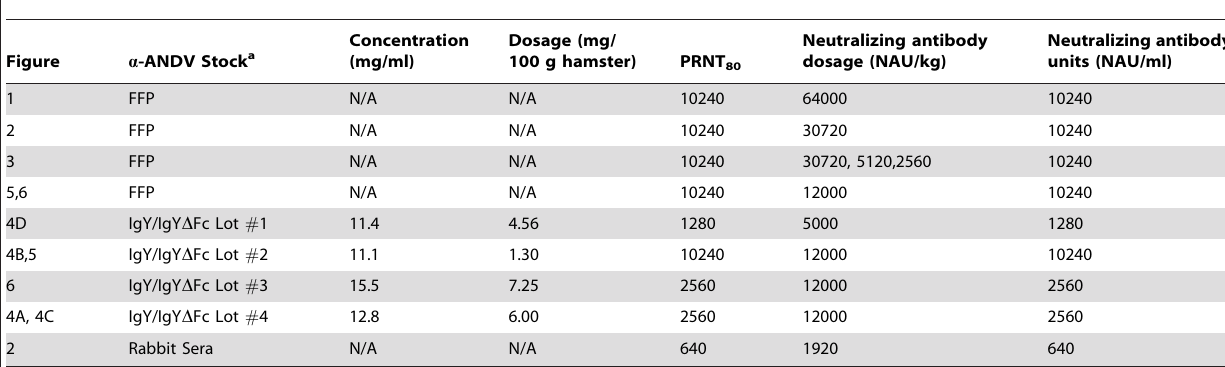
a FFP, fresh frozen plasma or duck IgY D Fc purified from vaccinated duck eggs.